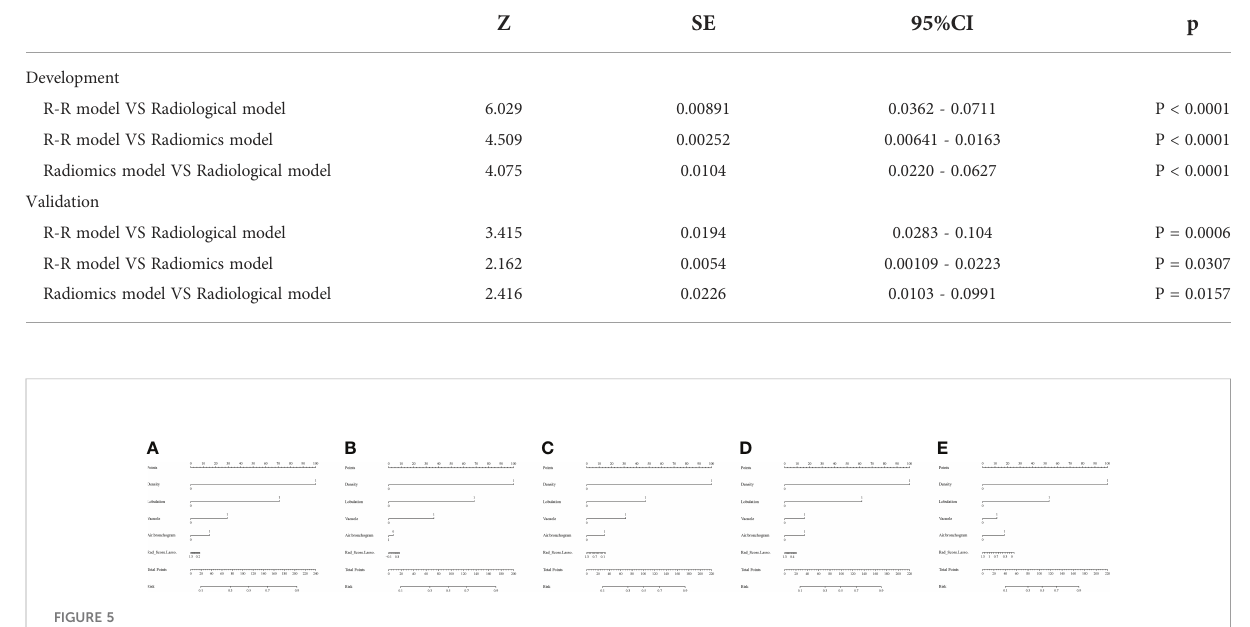
TABLE 4 Delong test results of Radiological model, Radiomics model and R-R model.